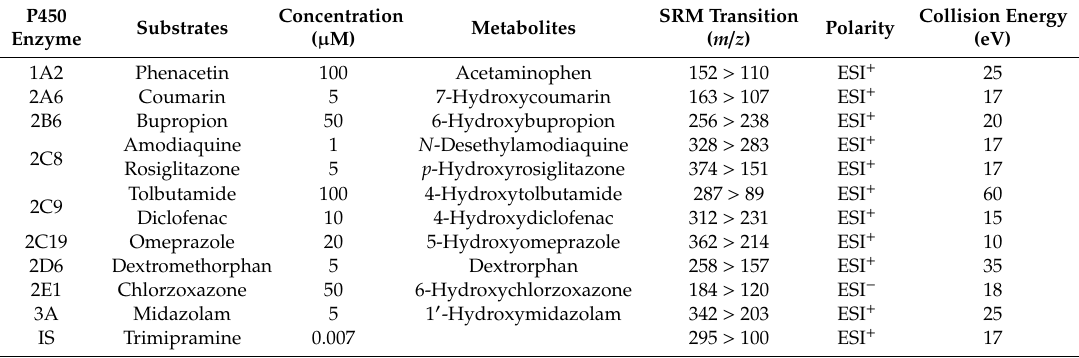
Table 1. Selected reaction monitoring (SRM) condition for the major metabolites of the nine cytochrome P450 probe substrates and internal standard